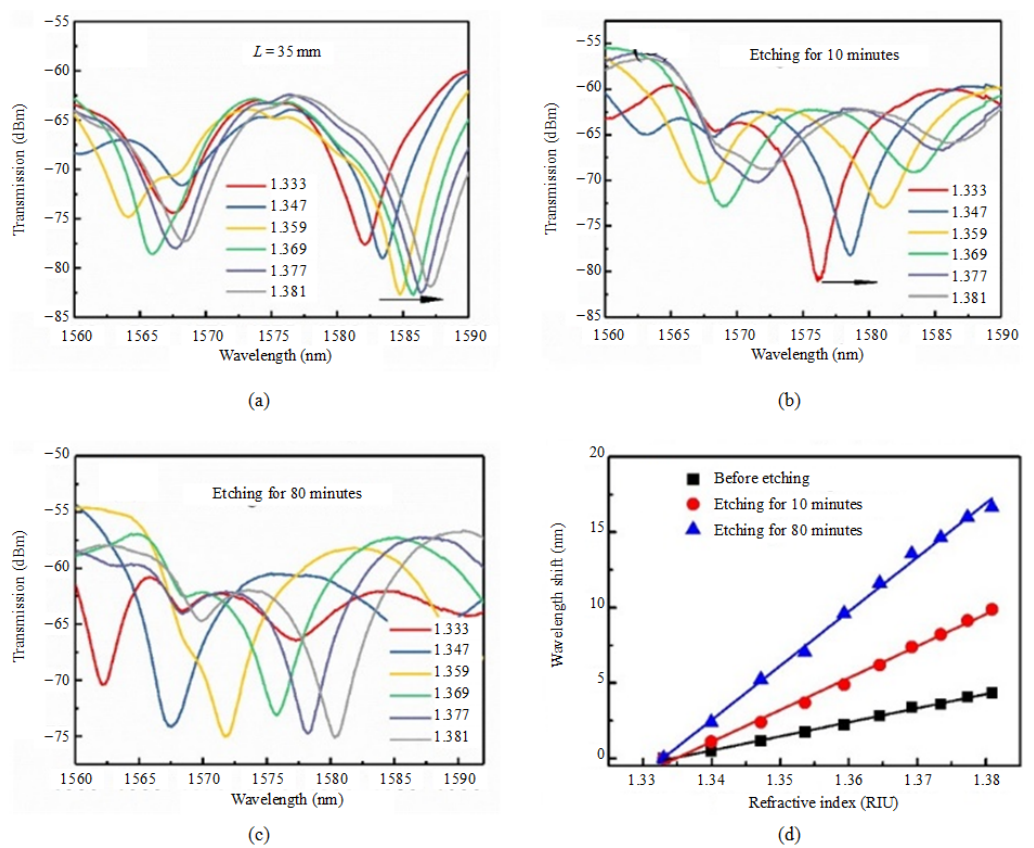
Fig. 7 Spectral change diagrams of (a) before corrosion, (b) etching for 10 minutes, (c) etching for 80 minutes, and (d) relationship between wavelength shift and surrounding RI of PCF interferometer with different etching